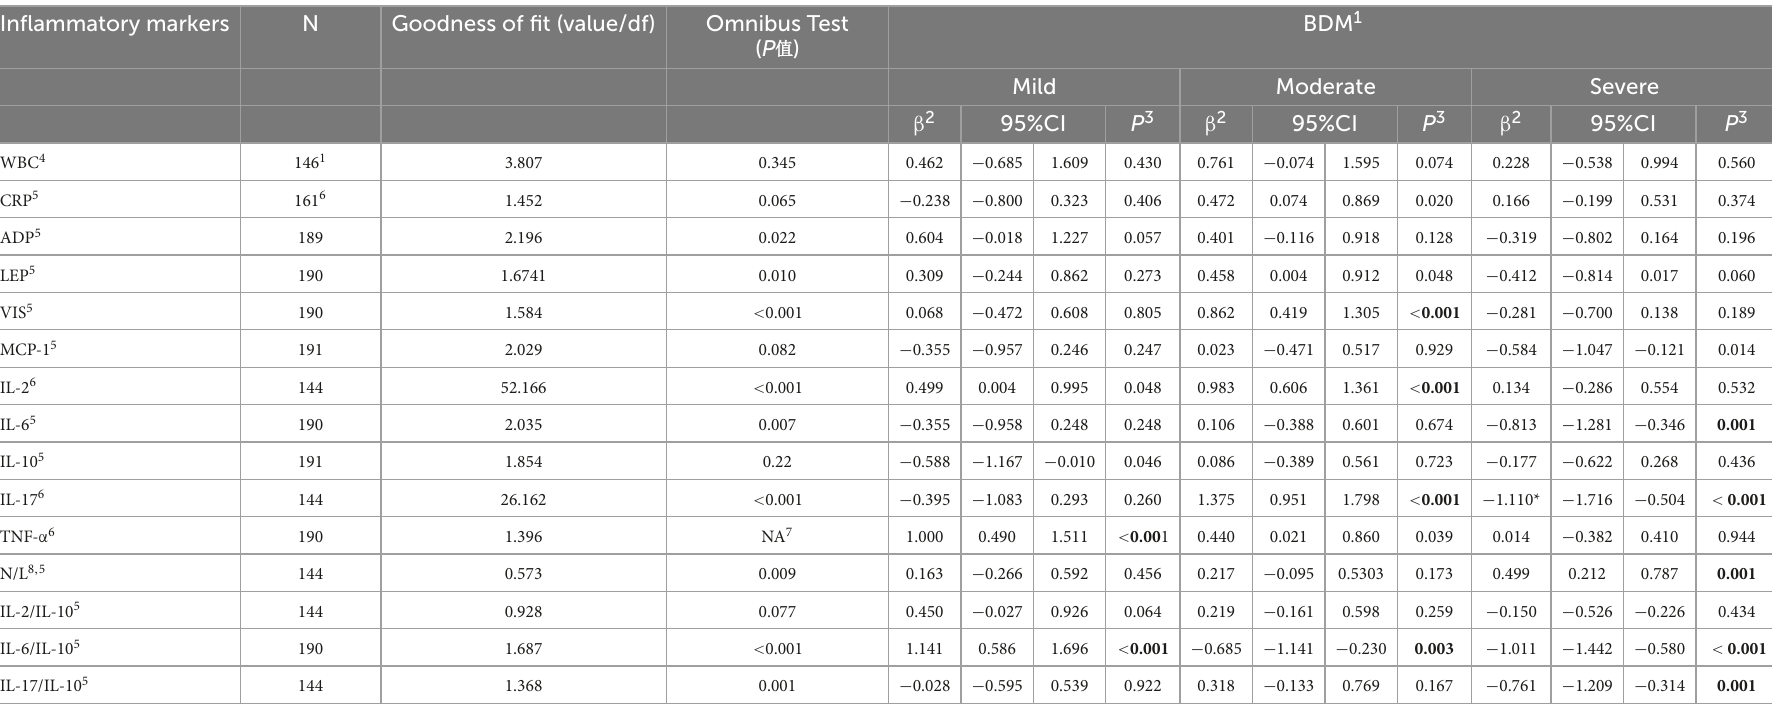
TABLE 6 The association between severity of manic symptoms and serum level of inflammatory markers. Inflammatory markers